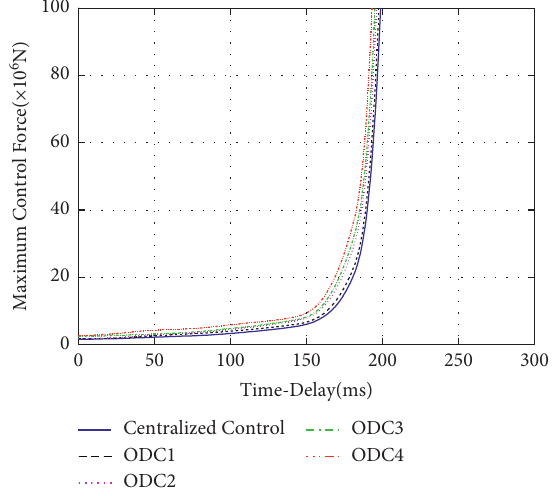
Figure 13: The maximum control force of first floor with time